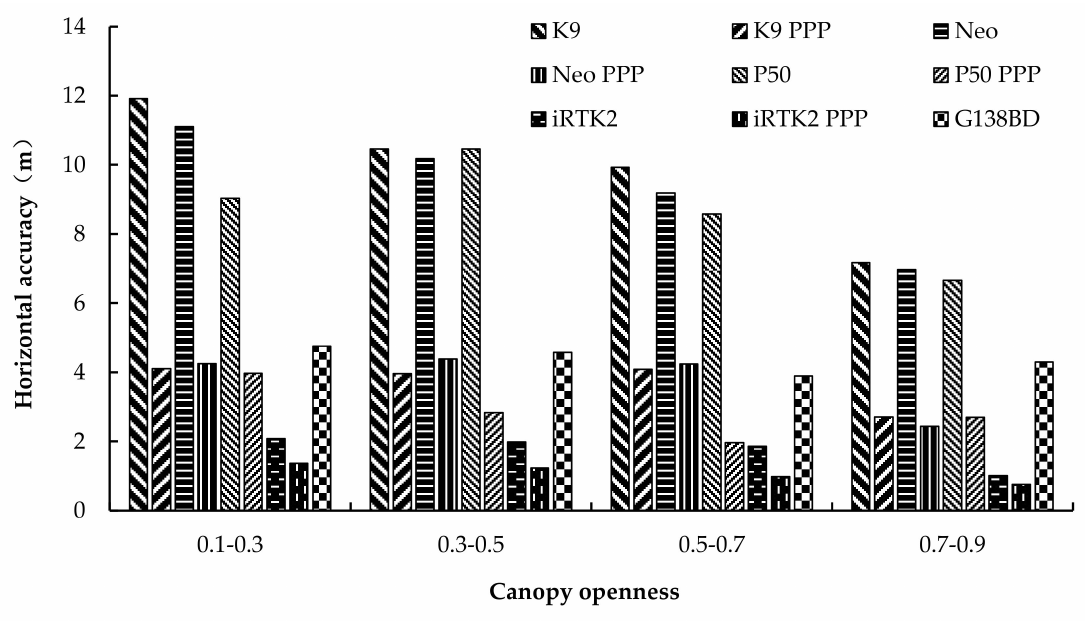
Figure 12. Horizontal accuracy comparison between SPP model and PPP model. Note: In the legend, if the device model is not marked, it refers to the accuracy of SPP, while marked PPP refers to the positioning accuracy processed by PPP